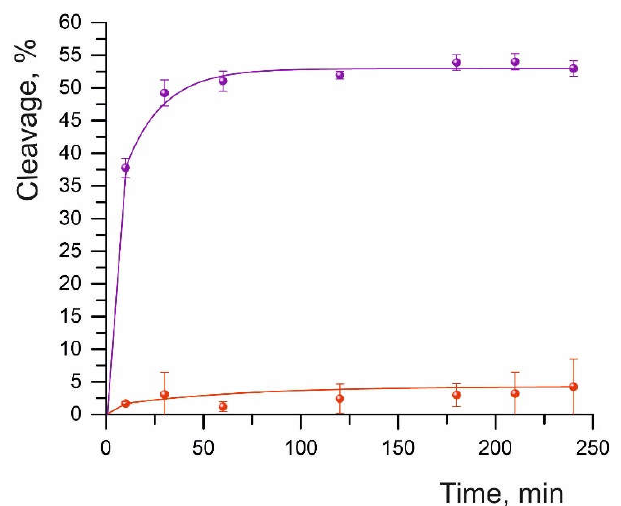
Figure 1. The time curve of the cleavage of substrate S01 (purple curve) and substrate S03 (red curve). The data were averaged from three independent experiments. Sequences of substrates S01 and S03 are presented in Table 1.